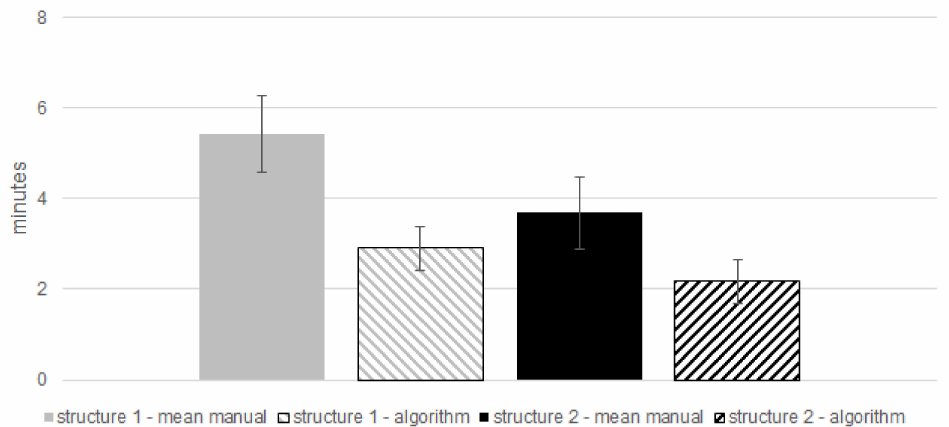
Figure 8. Mean time requirements per sub-image; mean manual–structure 1 (grey), algorithm–structure 1 (grey, dashed), mean manual–structure 2 (black), algorithm–structure 1 (black,